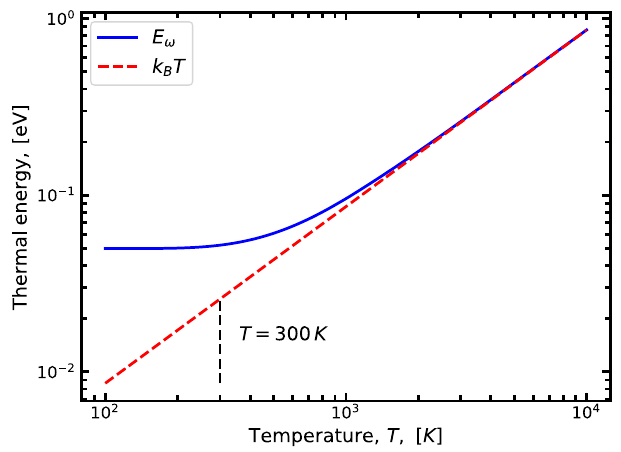
Fig. 3 Evidence for the breakdown of the high-temperature approximation. Comparing the high-temperature approximation to the thermal energy, k B T , (dashed red line) to the low-temperature correction, E ω , (the unbroken blue line) which saturates to the fi rst eigenstate energy at low